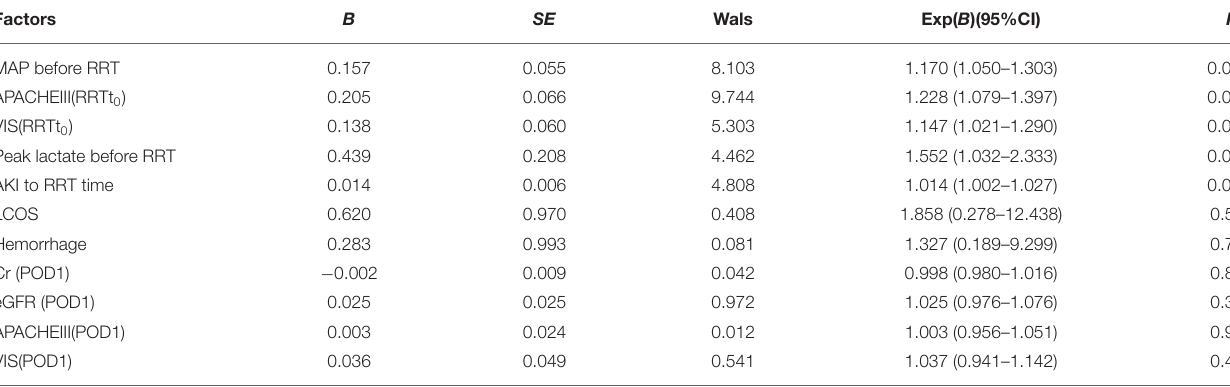
TABLE 7 | Results of multivariable logistic regression analysis.